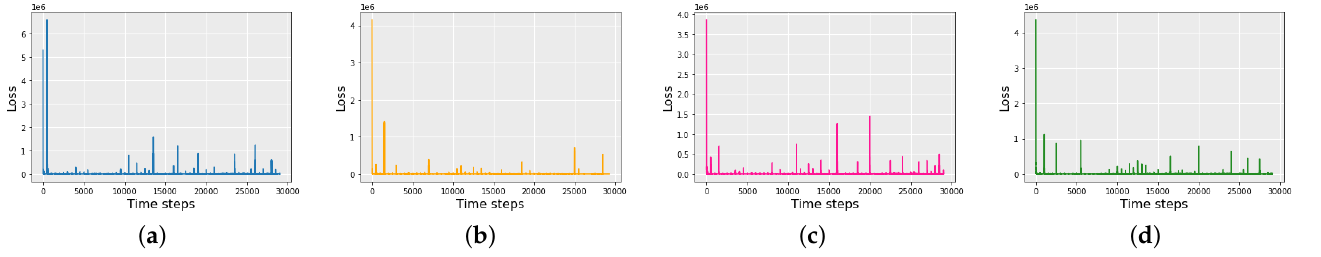
Figure 14. Loss convergence of the DQN algorithm in a heterogeneous leader-follower MAS, includ- ing N = 5 agents in P = 3 different clusters, during 30,000 time steps by considering time-delay and distance-based reward after adversarial attack defense Algorithm 2. ( a ) DQN average loss in a leader-follower MAS without adversarial attack. ( b ) DQN average loss in a leader-follower MAS after defending against FGSM adversarial attack. ( c ) DQN average loss in a leader-follower MAS after defending against FGM adversarial attack. ( d ) DQN average loss in a leader-follower MAS after defending against BIM adversarial attack.